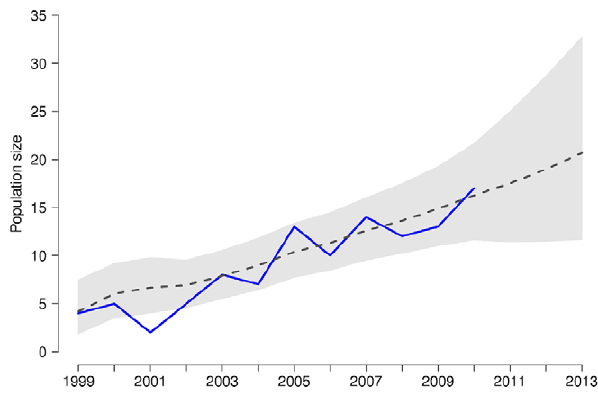
Figure 1. Observed and estimated sizes of the Red kite population of Mallorca (Spain), with a future projection of the number of breeding pairs. The blue solid line represents the surveyed population size, the black dashed line the predicted spring population sizes along with their 95%CRI (grey shading). doi:10.1371/journal.pone.0049187.g001 PLOS ONE |